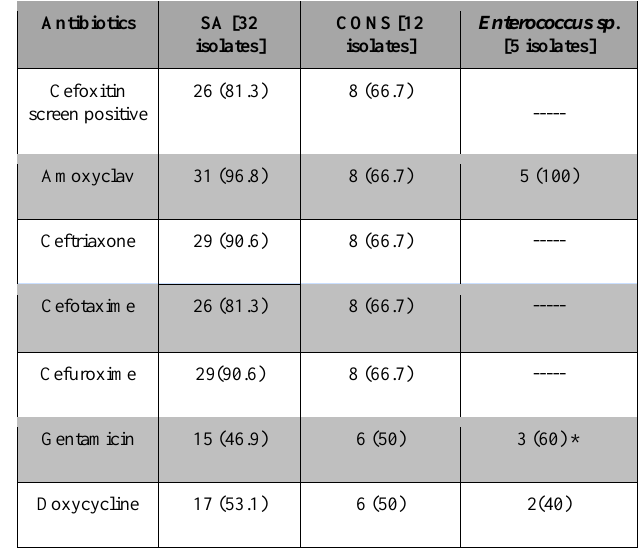
Table 1. Antibiotic resistance pattern of gram-positive isolates with percentage paradigm in paren-theses (n=